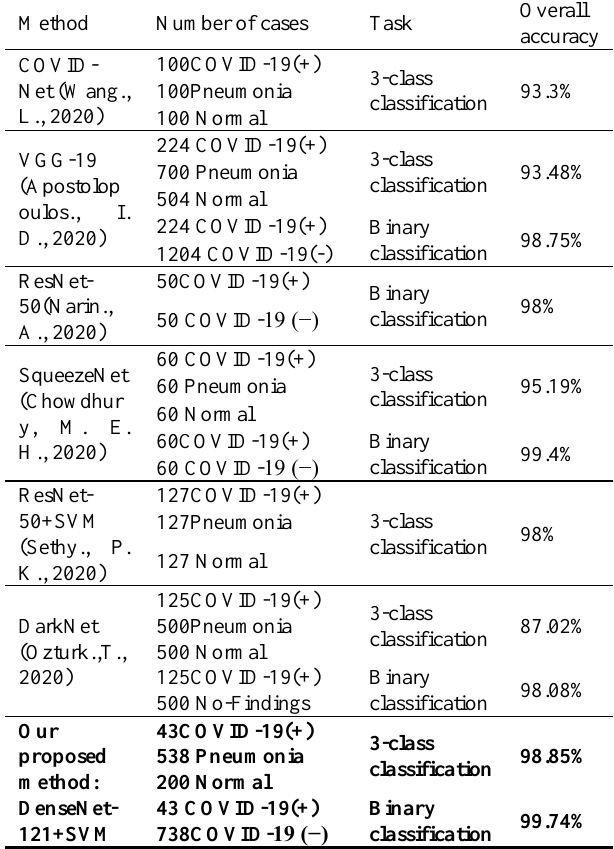
Table 5. Comparison to the state-of-the-art methods.